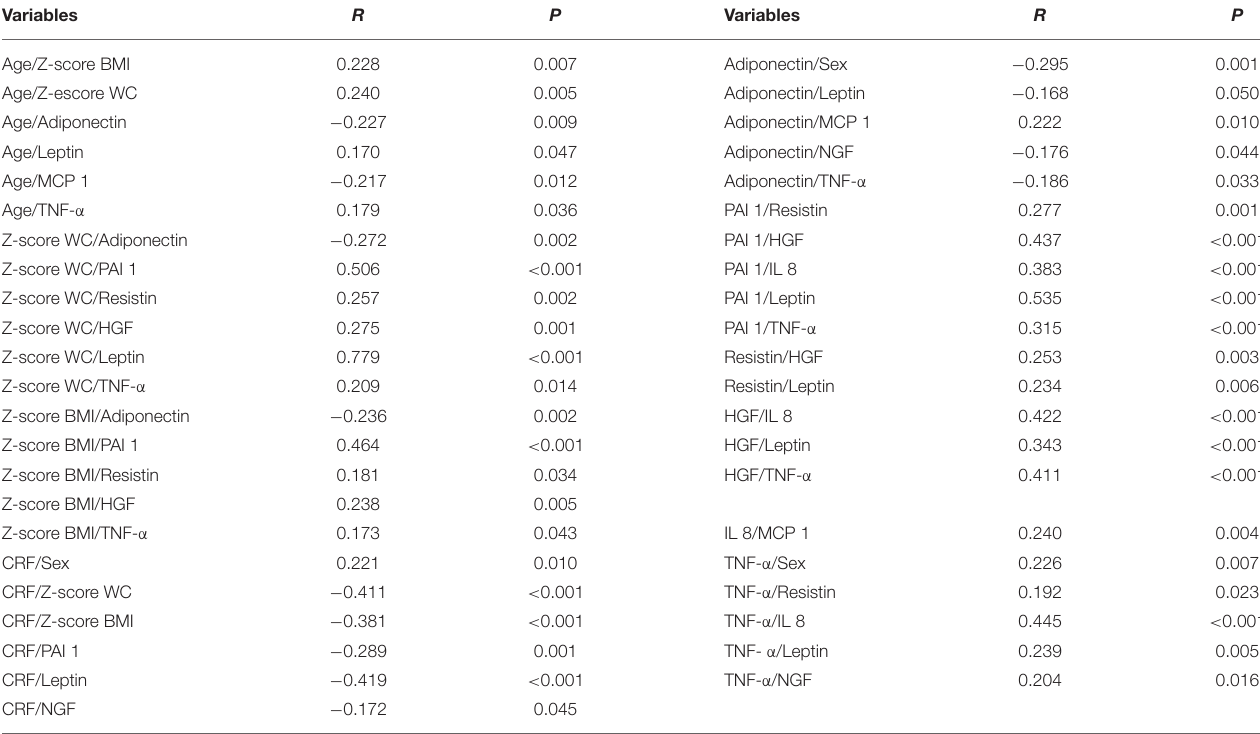
TABLE 4 | Significant correlations between adipokines, fitness, and demographic variables in healthy prepubertal children.